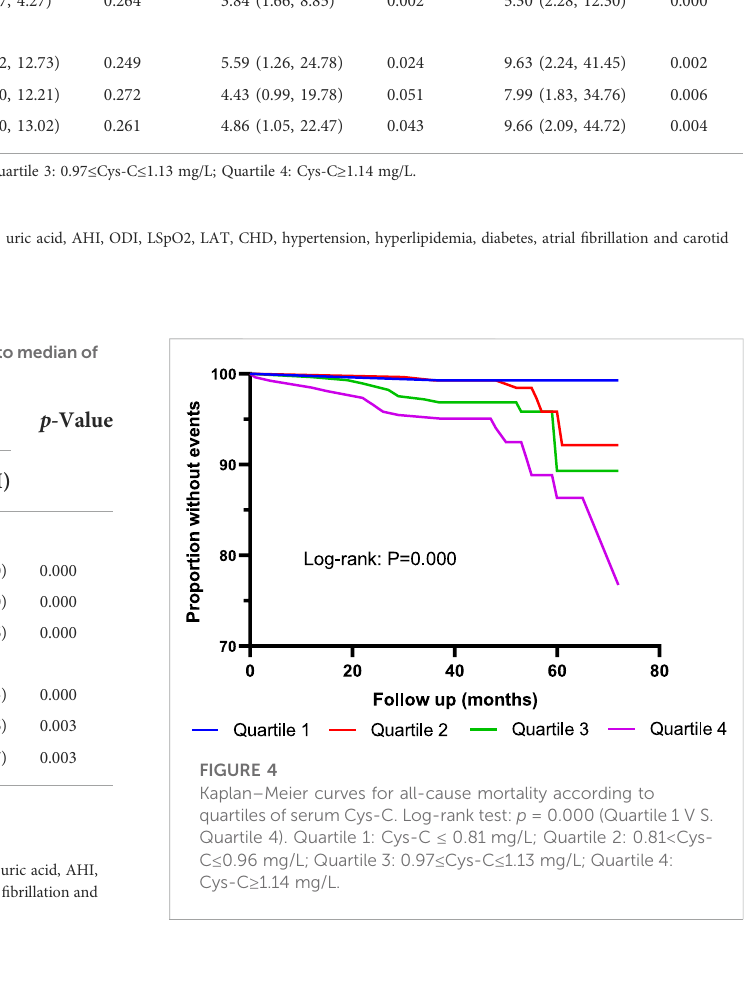
Model 3 All-cause mortality Model 1 Model 2